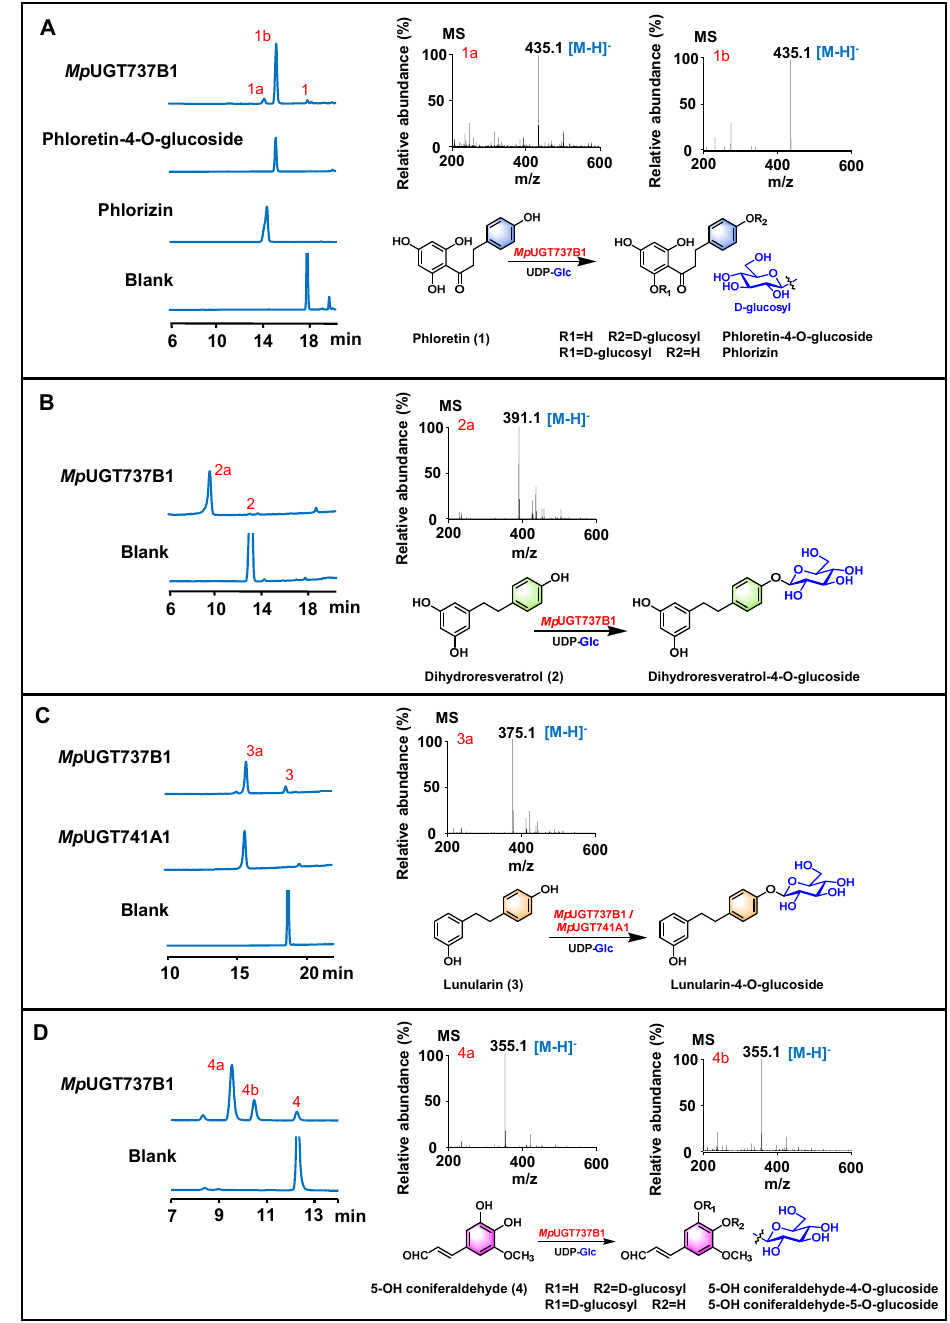
Figure 2. In vitro assays of recombinant Mp UGT737B1 and Mp UGT741A1 using UDP-glucose as the sugar donor. The HPLC analysis, product LC-MS analysis and catalytic reaction formula of the enzyme catalyzed reaction of Mp UGT737B1 with ( A ) phloretin, ( B ) dihydroresveratrol and ( D ) 5-OH coniferaldehyde as the substrate. The HPLC analysis, product LC-MS analysis and catalytic reaction formula of the enzyme catalyzed reaction of Mp UGT737B1 and Mp UGT741A1 with ( C ) lunularin as the substrate. To further explore the sugar donor promiscuity of the Mp UGTs, Mp UGT737B1 and Mp UGT741A1 were assayed with UDP-galactose and UDP-glucuronic acid as sugar donor, respectively. The results indicate that Mp UGT737B1 and Mp UGT741A1 only accept these two sugar donors as substrates at very low levels (Figure S6). Therefore, both enzymes display sugar donor specificity for UDP-glucose, as predicted by the PSPG motif sequence